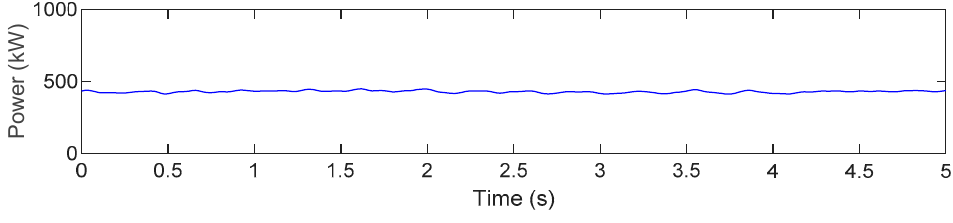
Figure 7. Active power of the LSPMSM SMH 1732T 630 kW motor during normal operation with filled ball mill.